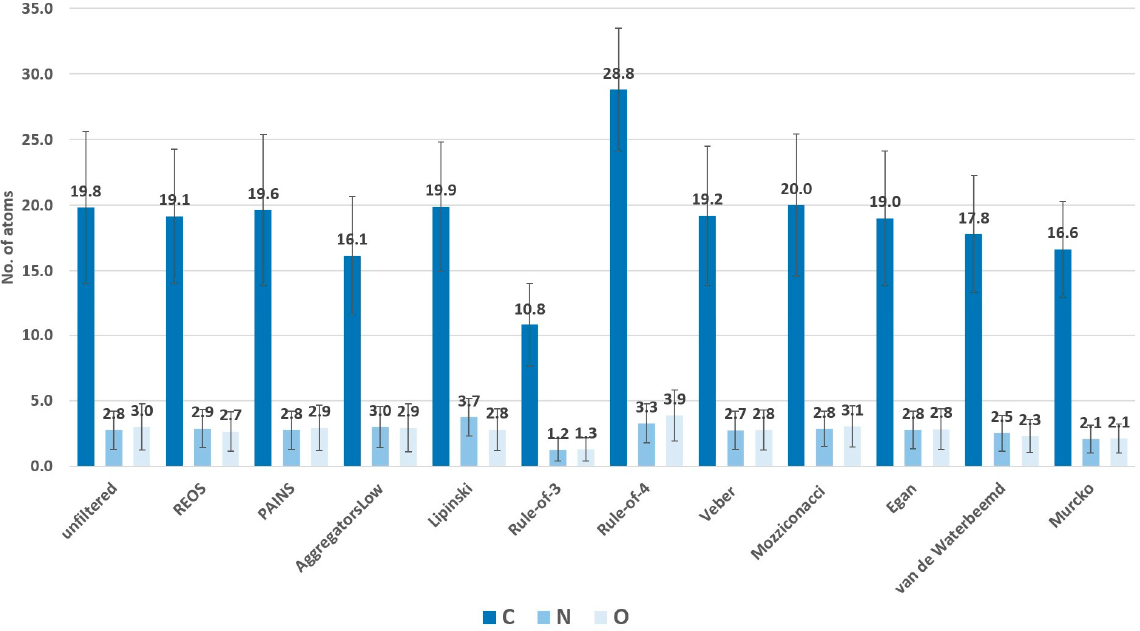
Figure 4. The average number of C, N, and O atoms present in the compounds. The majority of the libraries are within the average values of the unfiltered, with Rule-of-4 having higher values since the filter retains large molecules that are better suited for inhibiting protein–protein interactions. Rule-of-3 scores lower as it retains smaller compounds suitable for fragment-based drug design.